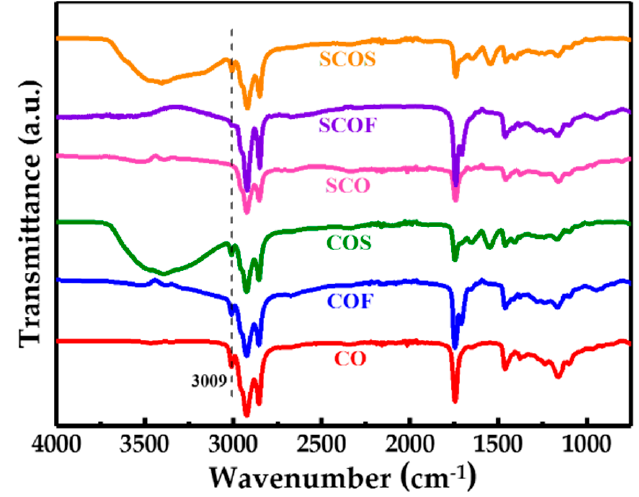
Figure 2. FT-IR spectrogram of the related samples (m S : m COX = 1:1).